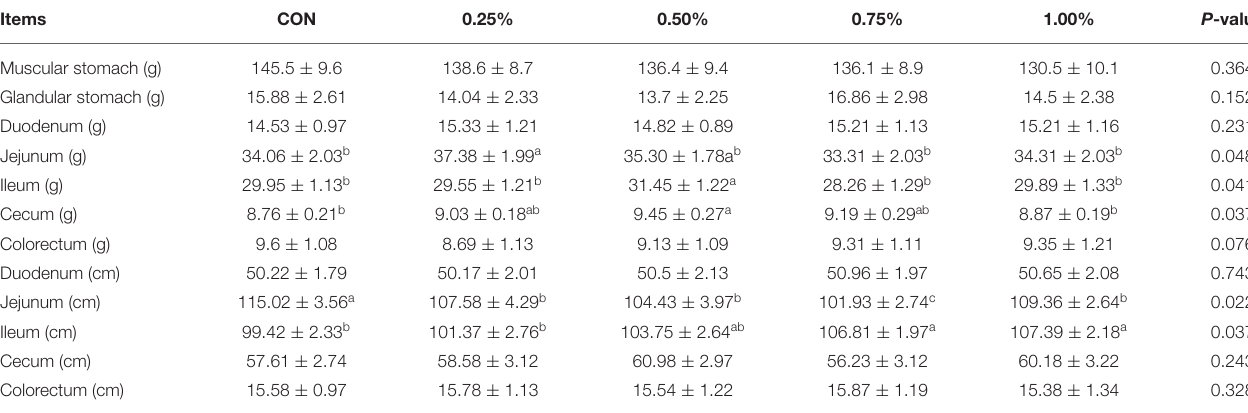
TABLE 4 | Effects of honeycomb flavonoids on gastrointestinal development ( n = 8).